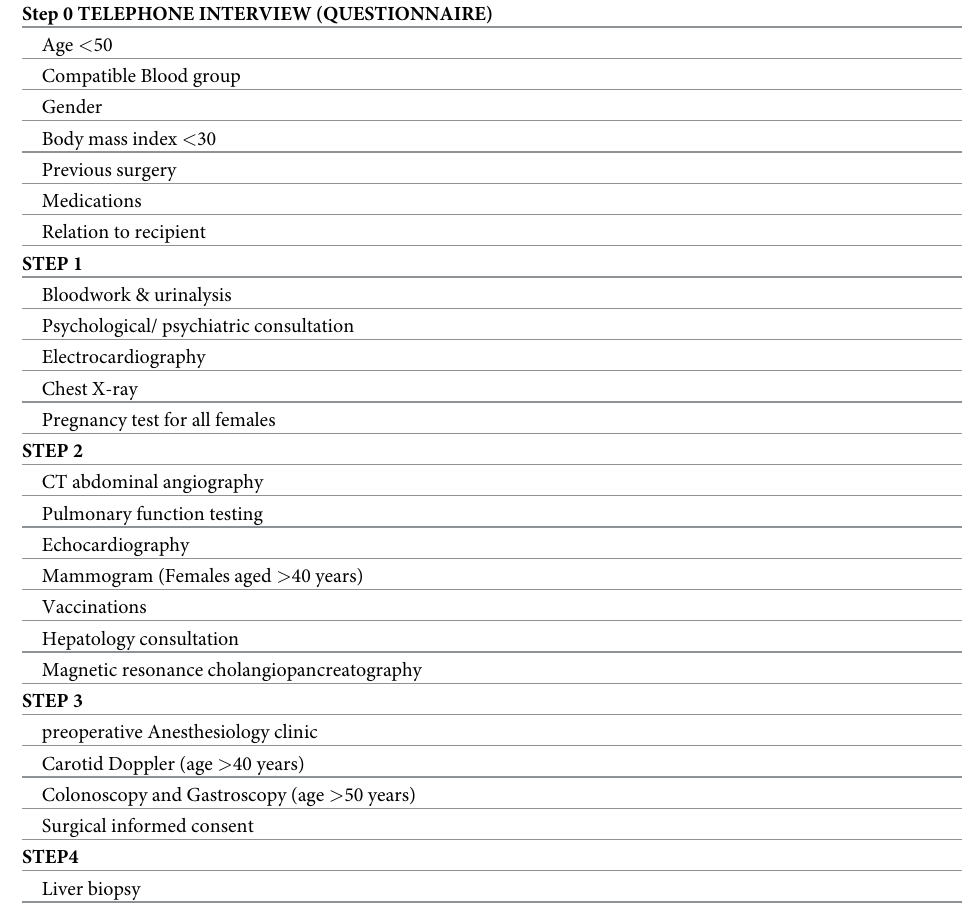
Table 1. Workup and steps for selection of living liver